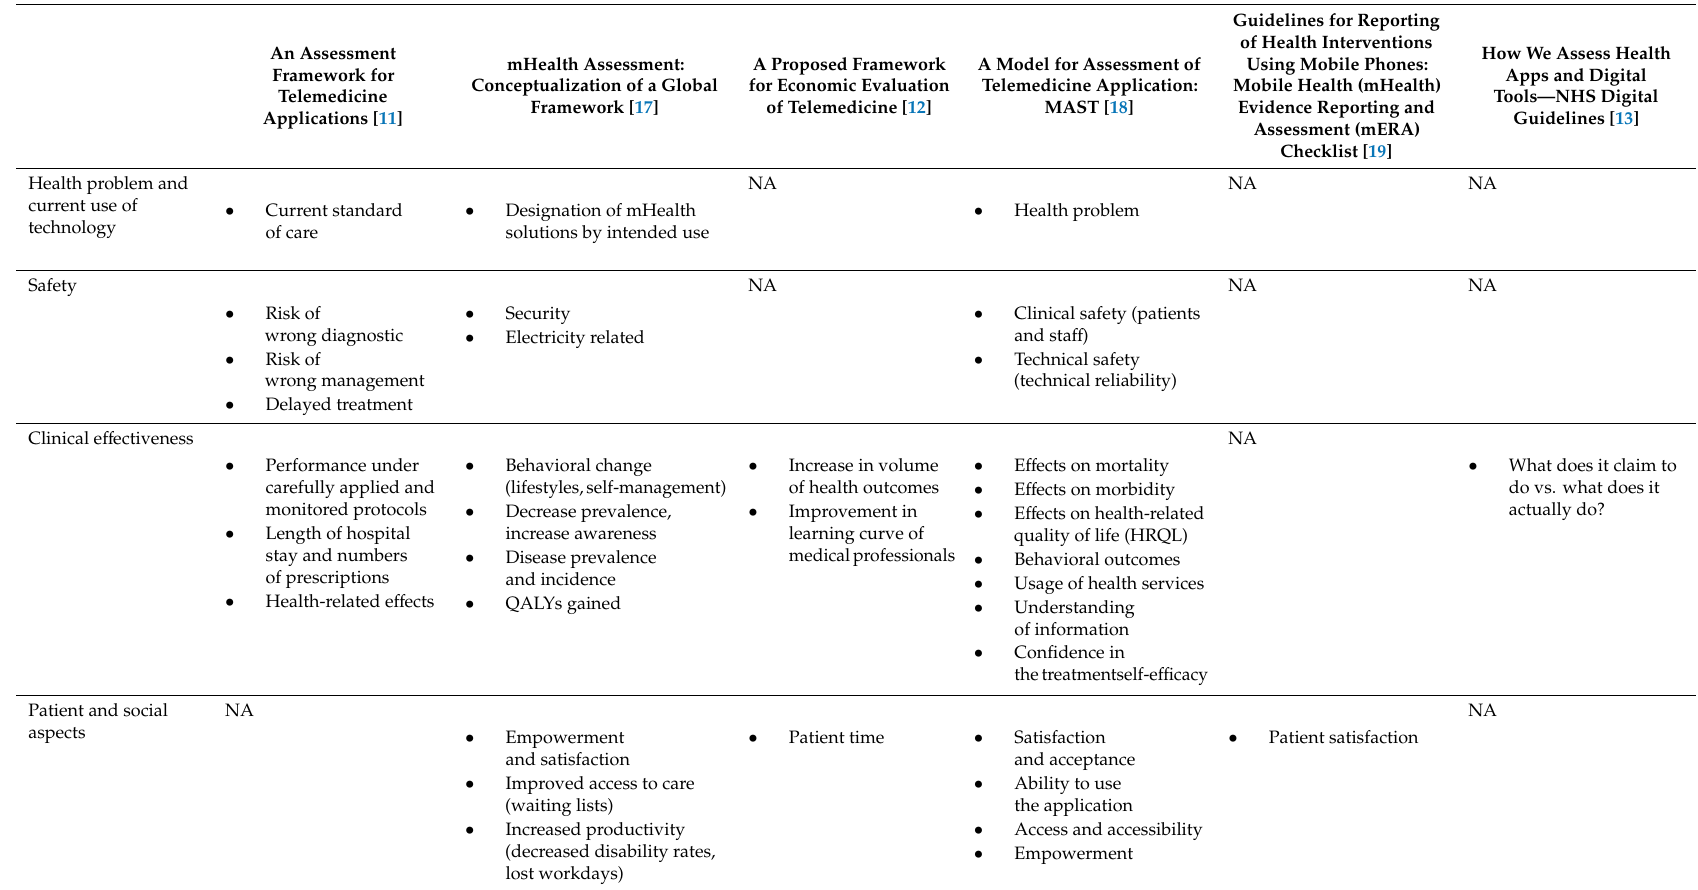
Table A3. Criteria